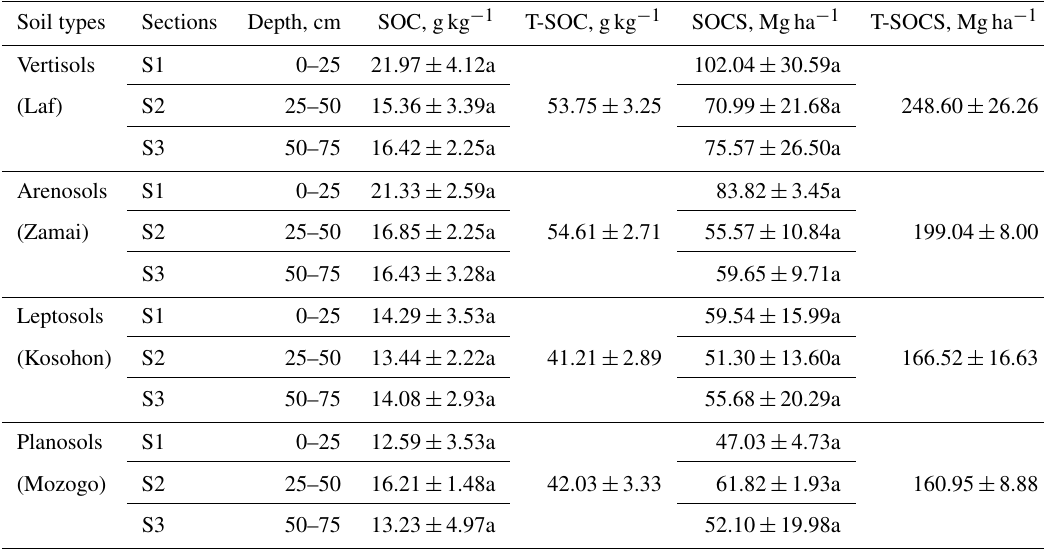
Table 5. Soil organic carbon (SOC) content and soil organic carbon stock (SOCS) (mean ± SD ∗ ) in the study area. Soil types